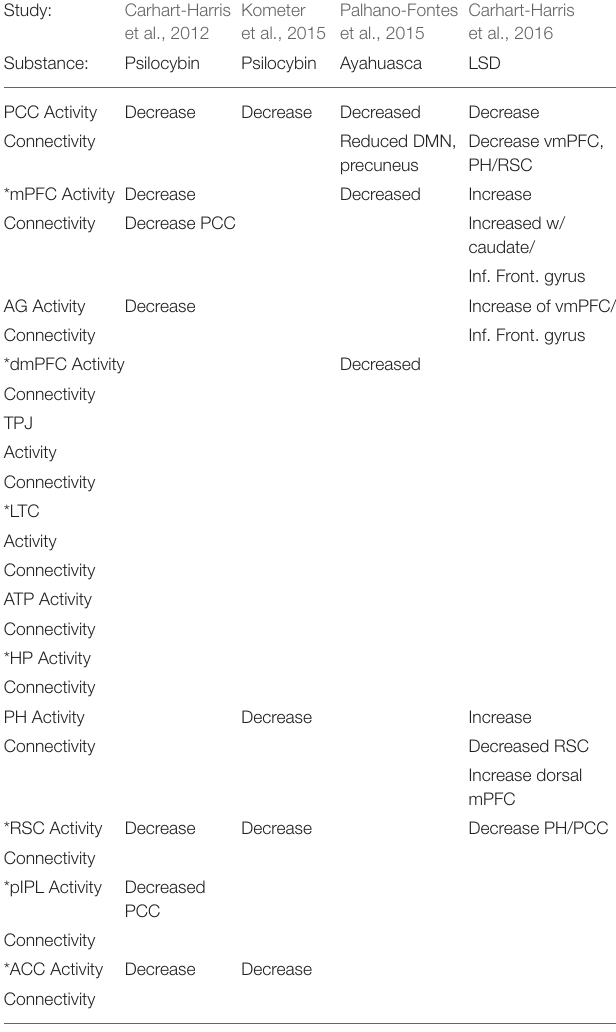
TABLE 1 | Psychedelic effects on the PFC and